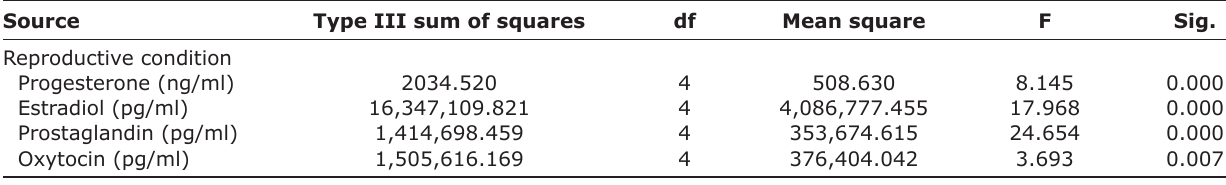
Table-3: Tests of between-subjects effects showing significant values of hormones in reproductive conditions (abortion, retained placenta, vaginal prolapse, dystocia, and downer cow syndrome).